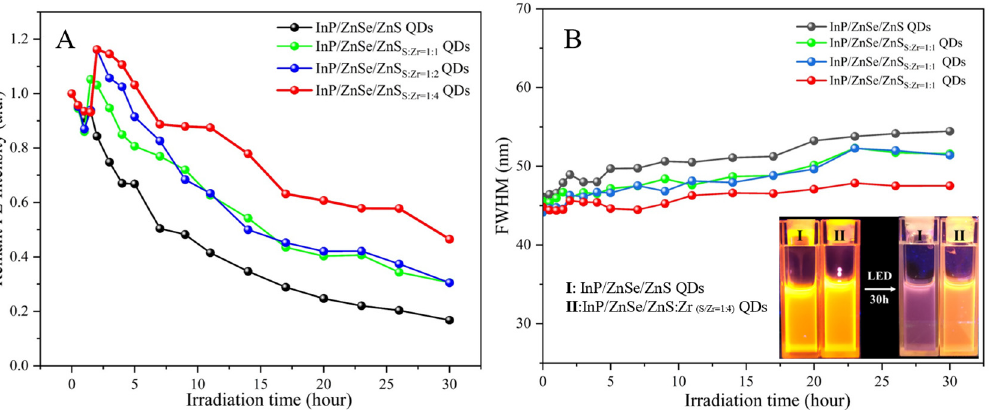
Figure 3. ( A ) The PL intensity and ( B ) FWHM of InP/ZnSe/ZnS and InP/ZnSe/ZnS:Zr QDs with different Zr concentrations under the irradiation of LED at 450 nm and 3.0 W over time.